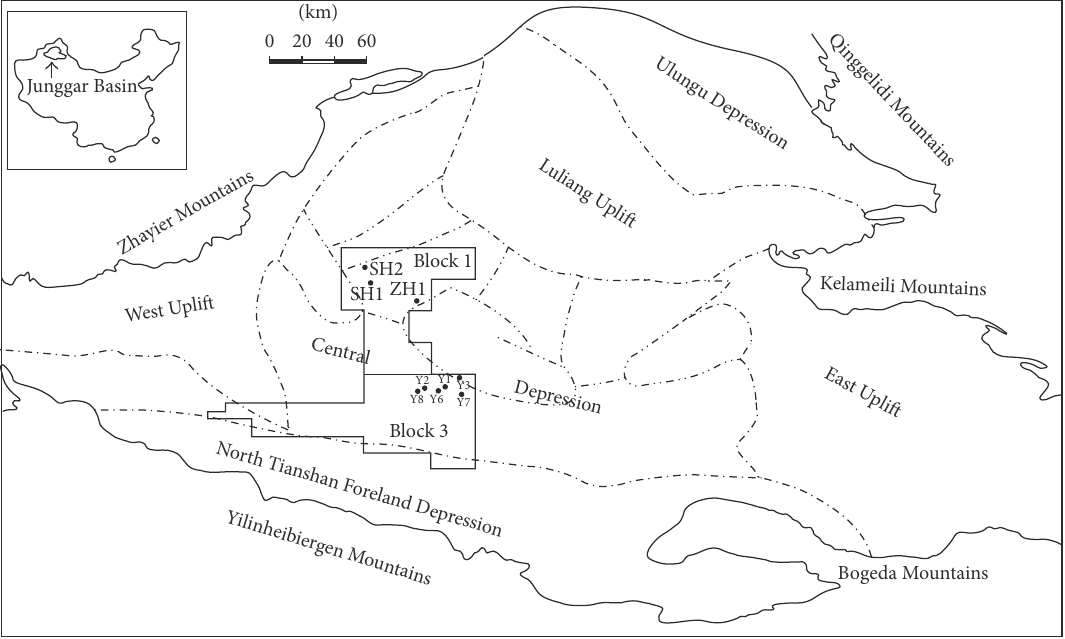
Figure 1: Map showing the tectonic units and studied well locations in the central Junggar